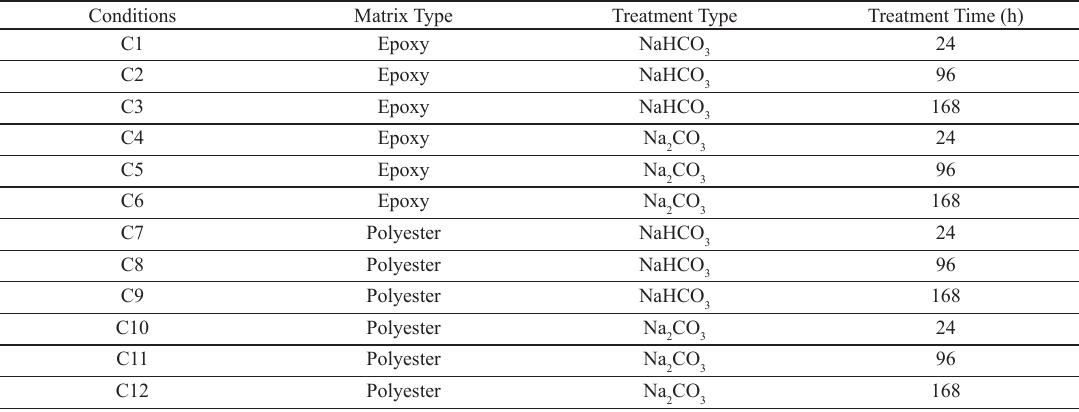
Table 1. Experimental conditions, full-factorial design (2 2 3 1 ).